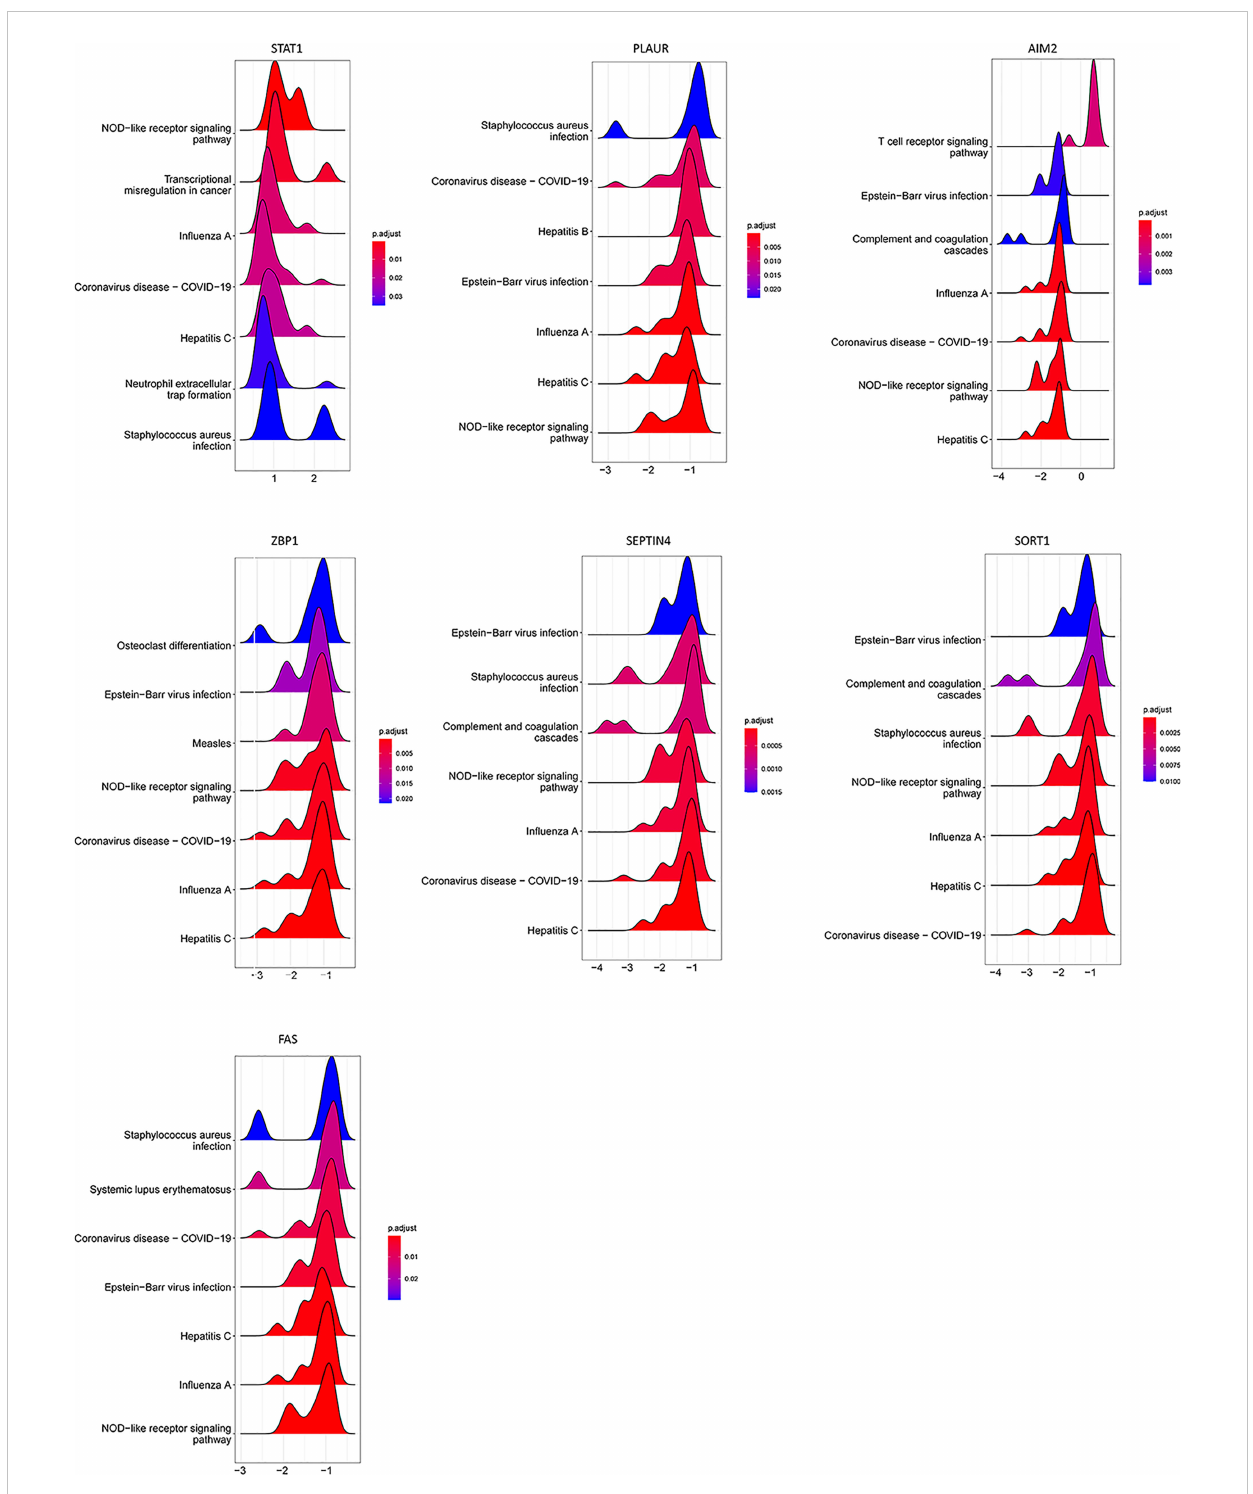
FIGURE 8 GSEA for samples with high and low PCD-related gene expression expression. The top seven enriched pathways in the high-low groups are